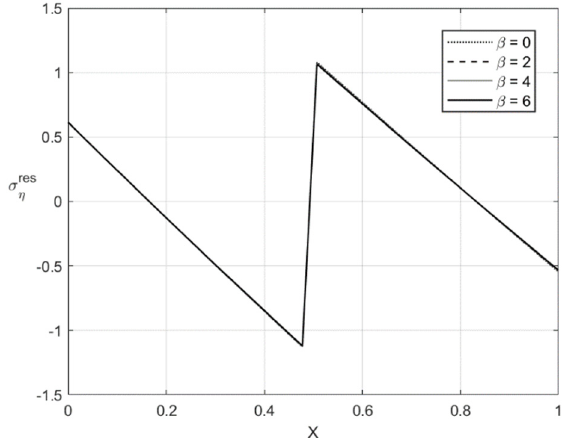
σ 0.06 H r = res σ 0.06 H r = res at , η CD at , η CD